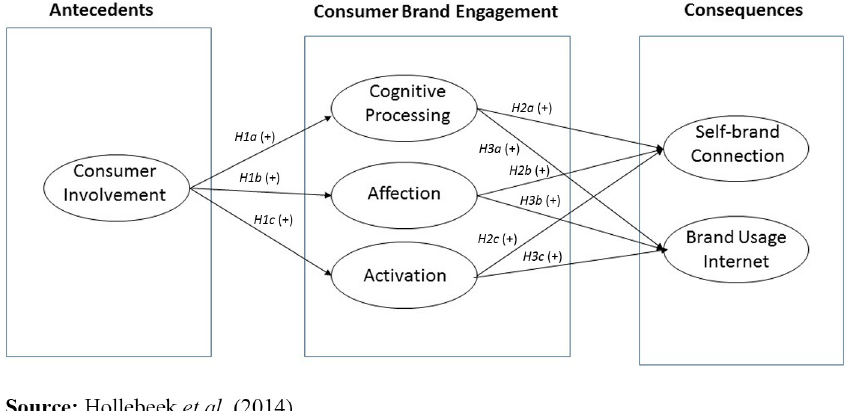
Figure 1. Conceptual